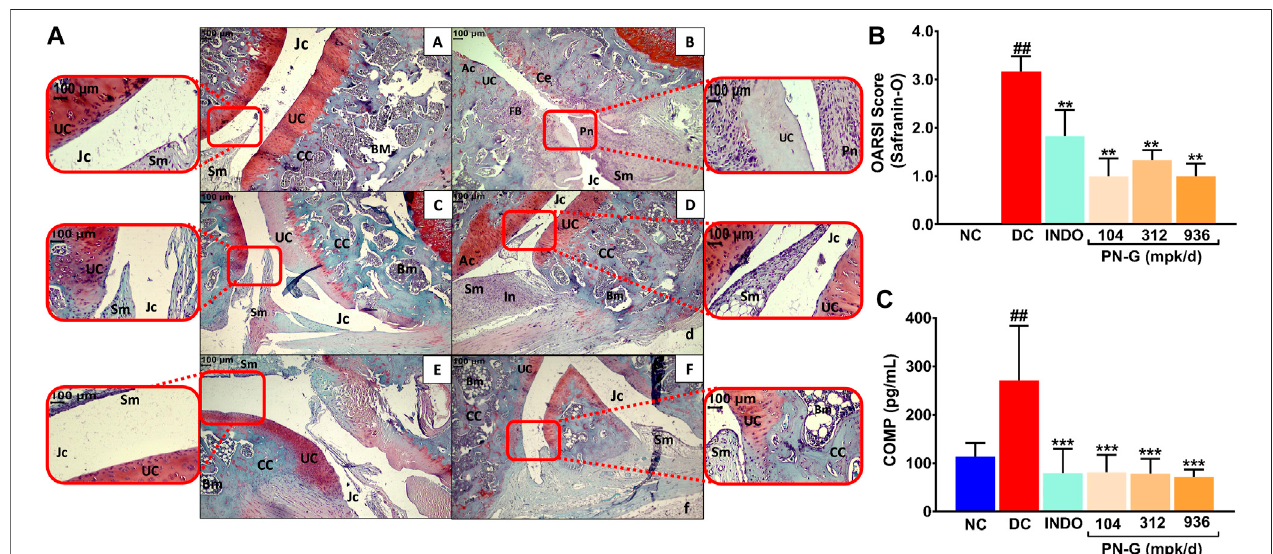
FIGURE 7 | PN-Gprotectsagainstcartilagedegeneration,acharacteristicanomalyrepresentativeofosteoarthritis. (A) RepresentativemicrographsofH-Eand SafraninO stained right knee joint sections, at ×10 and ×40 magni fi cations, from NC (A) , DC (B) , INDO (C) , PN-G 104 (D) , PN-G 312 (E) and PN-G 936 (F) groups depicting various histopathologicalfeatures,like,uncalci fi edcartilage(UC),calci fi edcartilage(CC),synovialmembrane(Sm),jointcavity(Jc)andbonemarrow(BM),cartilageerosion(Ce),super fi cial fi brillationofthearticularcartilage(FB),in fl ammation(In)andpannusformation(Pn). (B) BargraphdepictingtheOARSIscoreforextentofcartilagedegeneration. (C) Graphical representationoftheeffectofPN-Gtreatmentontheserumosteoarthriticbiomarker,CartilageOligomericMatrixProtein(COMP).Alldatapresentedasmean±SEM( n =6animals per group) and was statistically analyzed using one-way ANOVA followed by Dunnett ’ s multiple comparison test. ## depicts signi fi cant difference with respect to NC ( p < 0.01) whereas ** and *** show a statistically signi fi cant effect when compared to DC (** p < 0.01 and *** p <